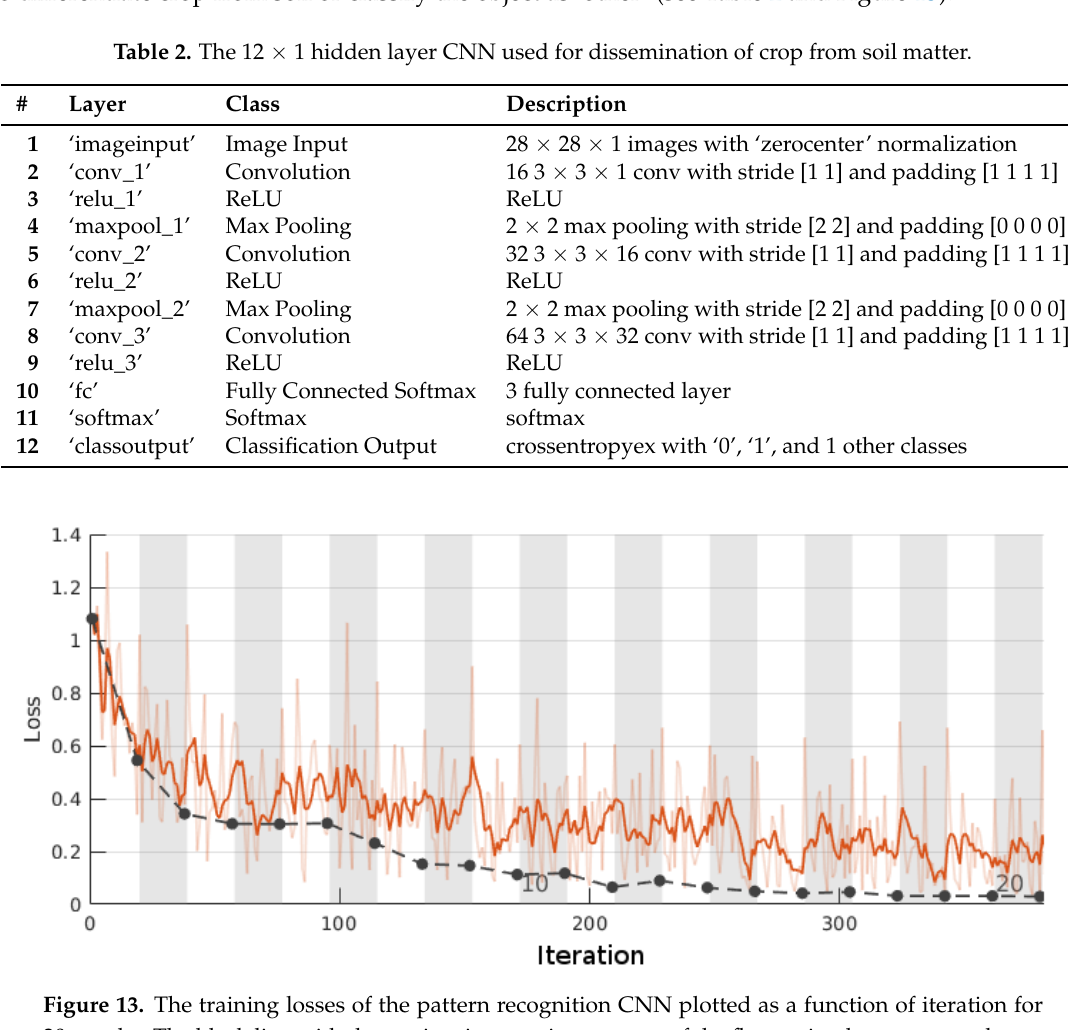
Figure 13. The training losses of the pattern recognition CNN plotted as a function of iteration for 20 epochs. The black line with data points is a moving average of the fluctuating loss patterns shown above